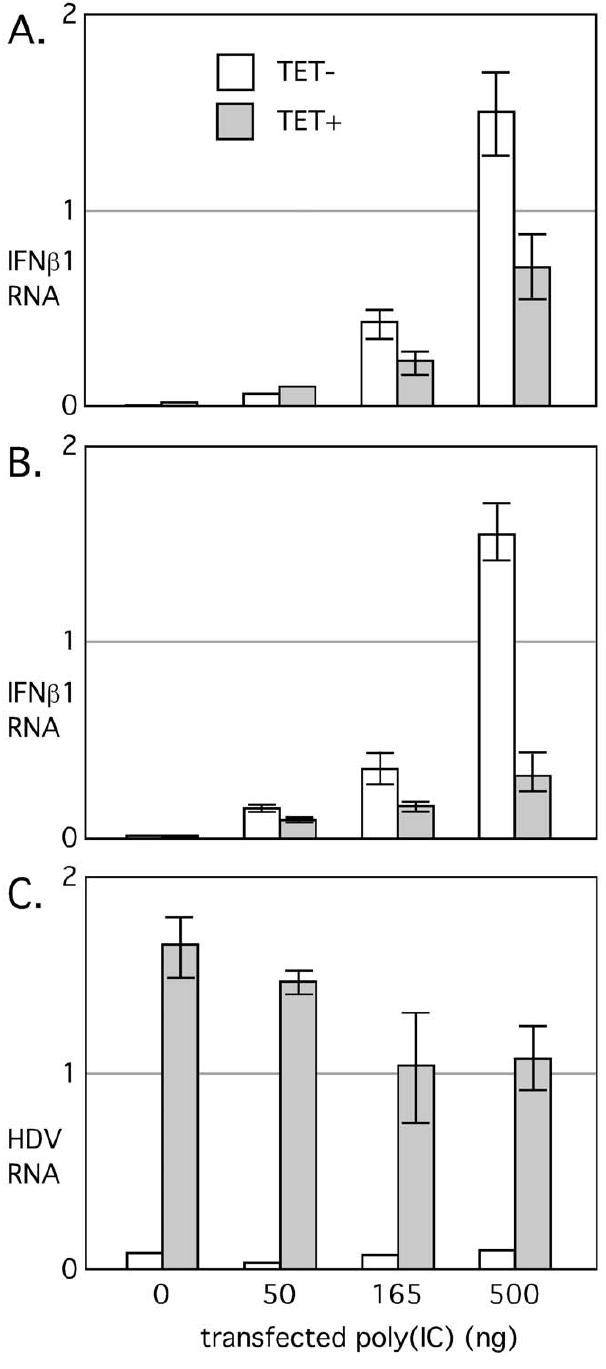
Figure 1. Transfection of poly(IC) into 293- d Ag and 293-HDV cells, with and without TET induction. Panel A: 293- d Ag cells in a 24-well format were transfected with the indicated amounts of poly(IC) and after 6 h induced with or without TET. At 24 h total RNA was extracted and assayed by realtime PCR for interferon-beta1. Panels B and C: As in A, but using 293-HDV cells. In B and C the assays are for interferon-beta1 and HDV RNA, respectively. The experiment was performed in triplicate. Values are expressed in arbitrary units along with the standard error of the mean which includes the errors in both the control and the treated